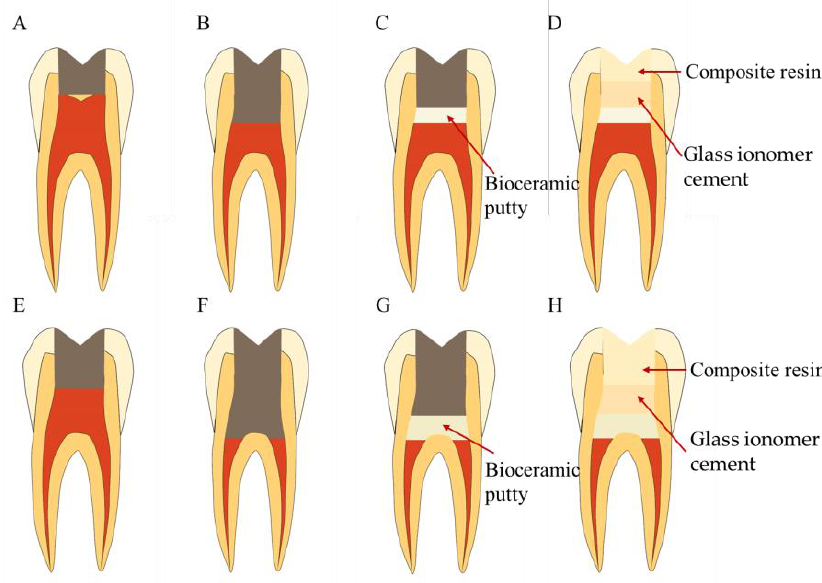
Figure 8. Treatment procedures for pulpotomy. ( A – D ) Treatment procedures for partial pulpotomy. ( A ) Caries or defect in contact with the pulp. ( B ) Removal of part of the coronal pulp. ( C ) Pulp capping with bioceramic putty. ( D ) Coronal filling. ( E – H ) Treatment procedures for complete pulpotomy. ( E ) Caries or defect in contact with the pulp. ( F ) Removal of all the coronal pulp. ( G ) Pulp capping with bioceramic putty. ( H ) Coronal filling.